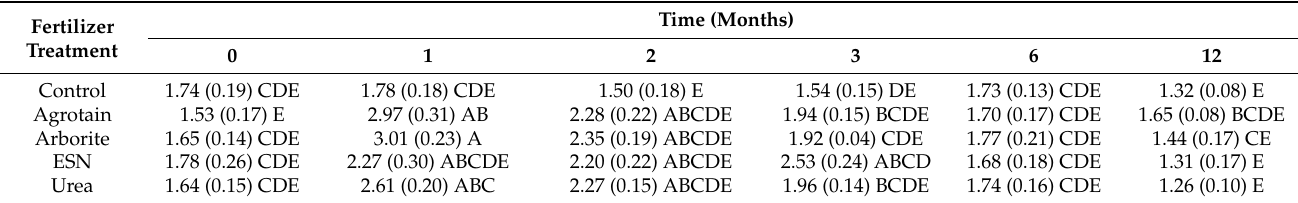
Table 5. Competing vegetation N concentration (%) in response to fertilizer treatments and time. Table entries are means ( ± standard error of the mean) for each fertilizer treatment × time combination ( n = 8). Means throughout the table marked with the same letters did not differ significantly ( α = 0.05).